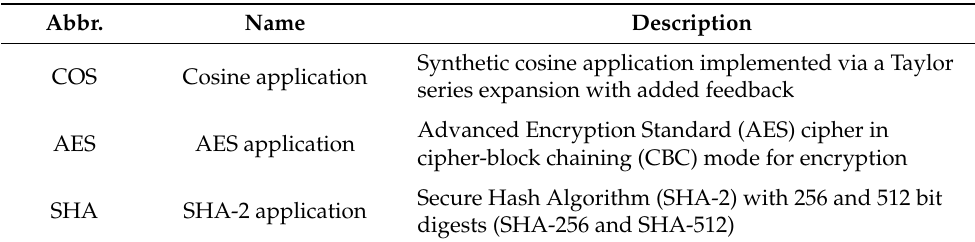
Table 2. Applications implemented using C -slow techniques.